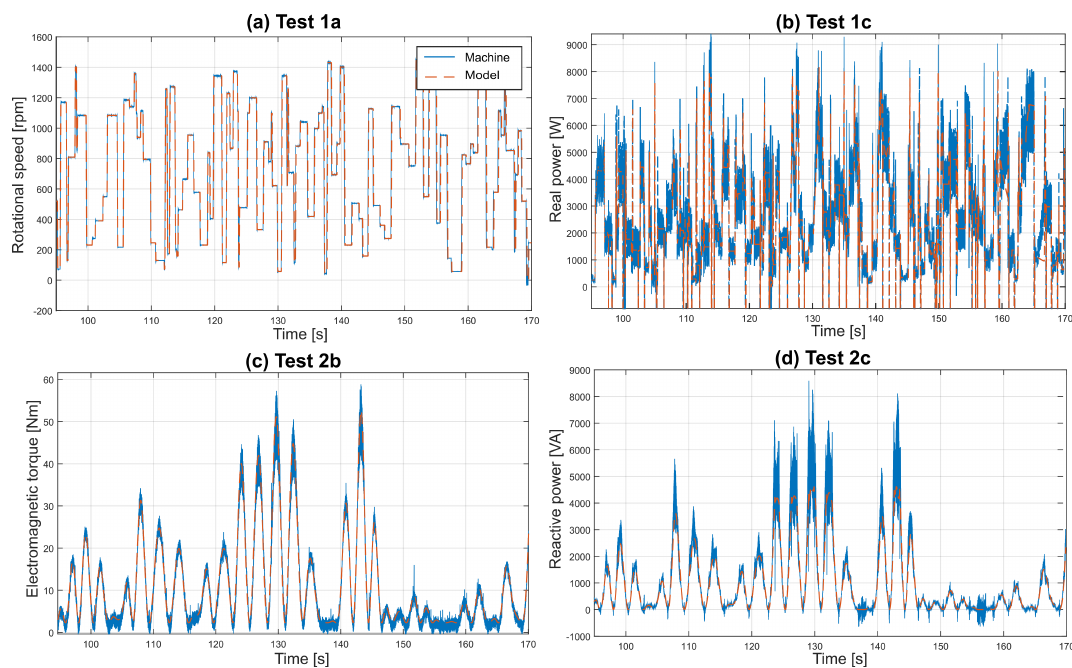
Figure 12. Comparing results from experiments and numerical models for the SCIG: rotational speed for Test 1a ( a ), real power for Test 1c ( b ), electromagnetic torque for Test 2b ( c ) and reactive power for Test 2c ( d